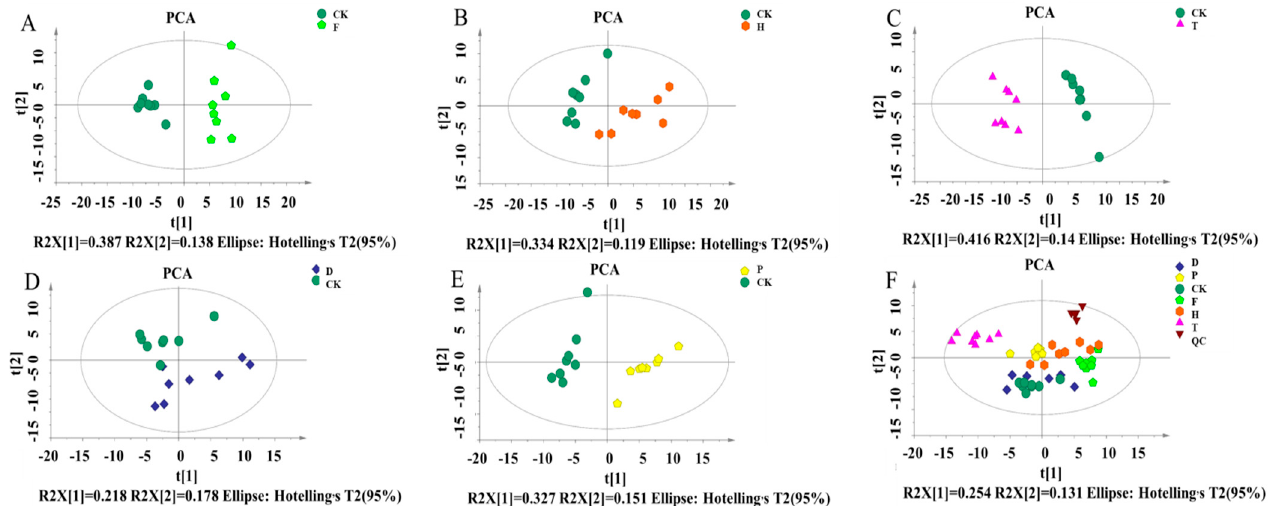
Figure 3. PCA diagram of different metabolites collected during wine fermentation with the treatment of different pesticides. ( A ) CK and F; ( B ) CK and H; ( C ) CK and T; ( D ) CK and D; ( E ) CK and P; ( F ) All collected data are within the 95% confidence interval. Red represents the CK group, yellow represents the F group, light blue represents the H group, purple represents the T group, green represents the D group, blue represents the P group, and light purple represents the QC group. Note: CK, blank control group; F, flutriafol; H, hexaconazole; T, tebuconazole; D, difenoconazole; P, propiconazole.